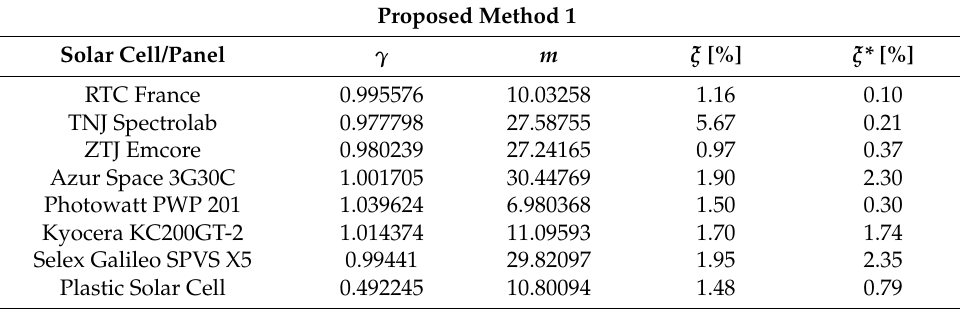
Table 5. Parameters from Karmalkar and Haneefa’s explicit model Equation (19)), fitted to the I – V curves for the photovoltaic devices studied (see Table 1). The fittings were performed numerically (best fit), and using the methodologies proposed (proposed method 1: Equation (20); (proposed method 2: Equation (22); and (proposed method 3: Equation (24)). The normalized RMSE values of the fittings, ξ , and ξ * , are included in the